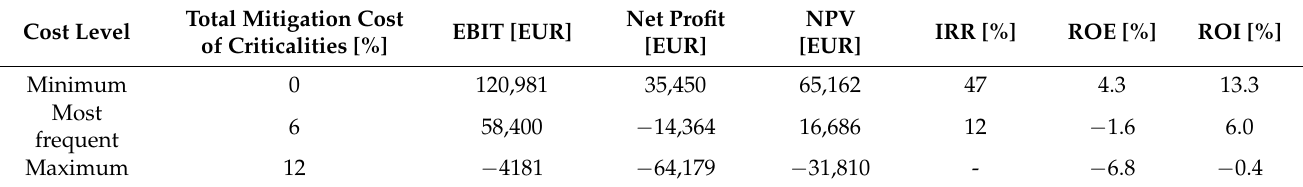
Table 14. Results of the sensitivity analysis conducted considering critical levels typical of multi- family construction after the introduction of CILAS and assuming critical mitigation costs equal to the minimum, maximum, and most frequent